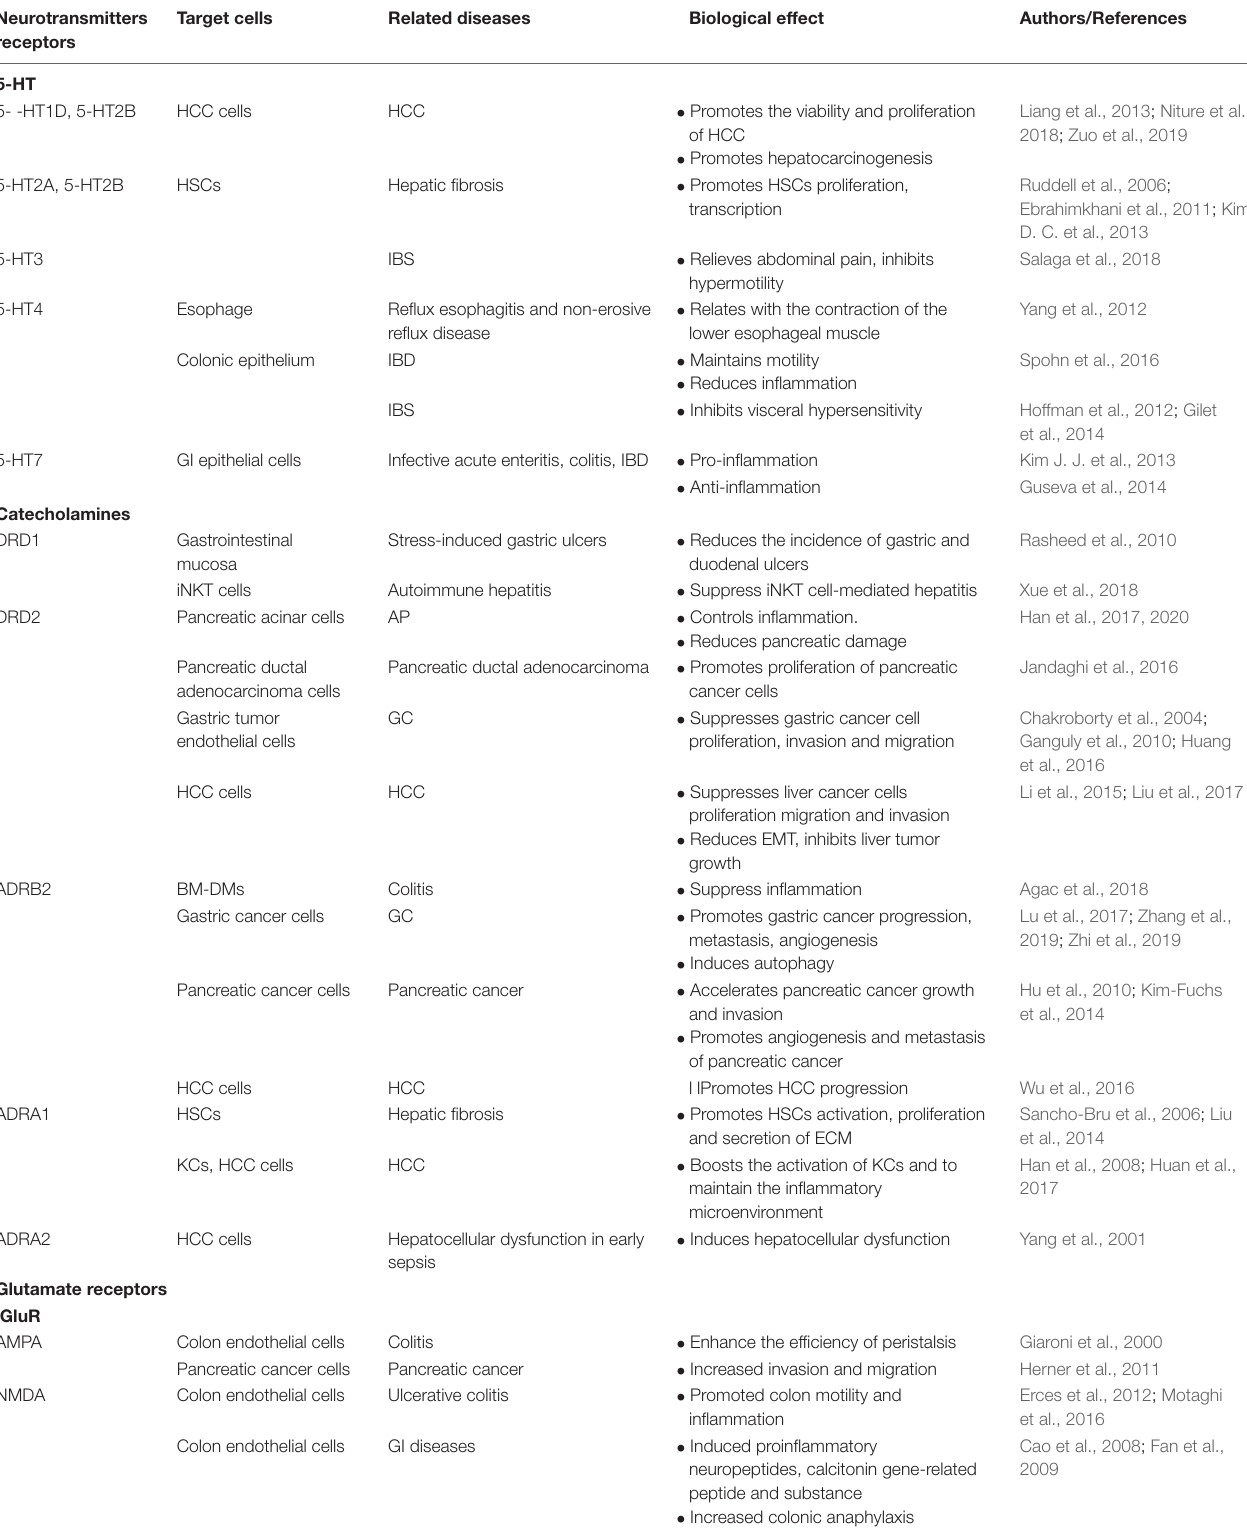
TABLE 1 | A summary of roles of neurotransmitters receptors in the pathological mechanism of digestive diseases. Neurotransmitters